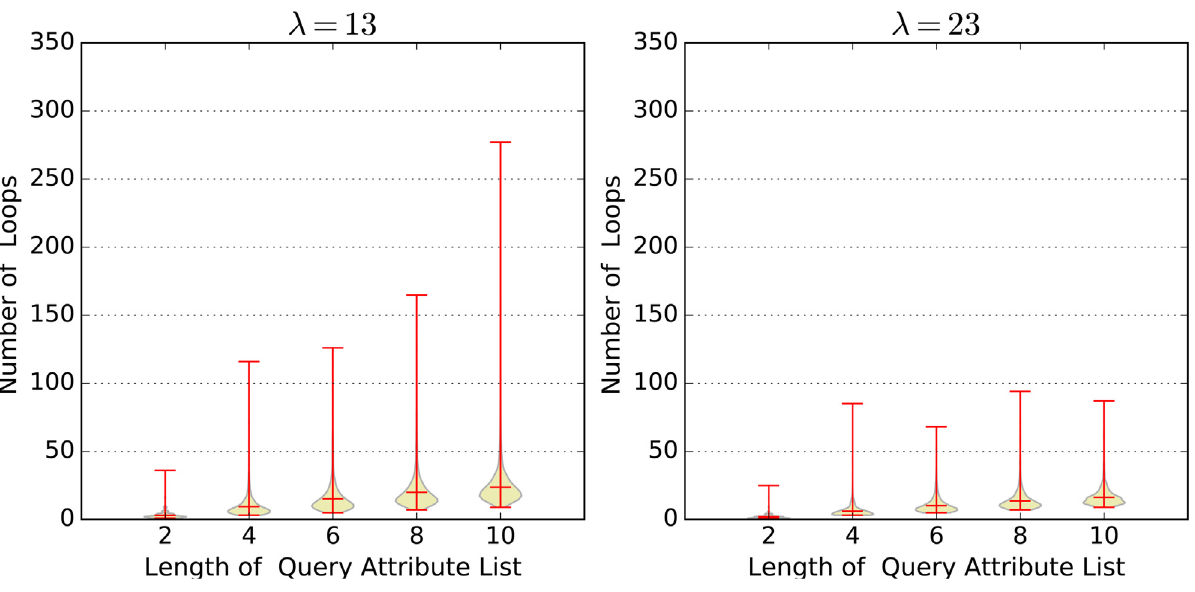
Fig 5. The number of loops in funciton